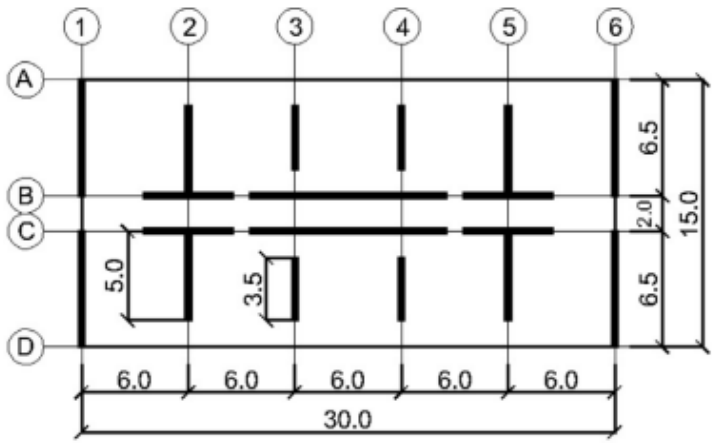
Figure 1. Plan view of the structure (dimensions in meters), adapted from Cando et al. [17]. Table 1. Properties of the buildings’ seismic design. Table 2. Summary of the design with Grade 60 reinforcement.